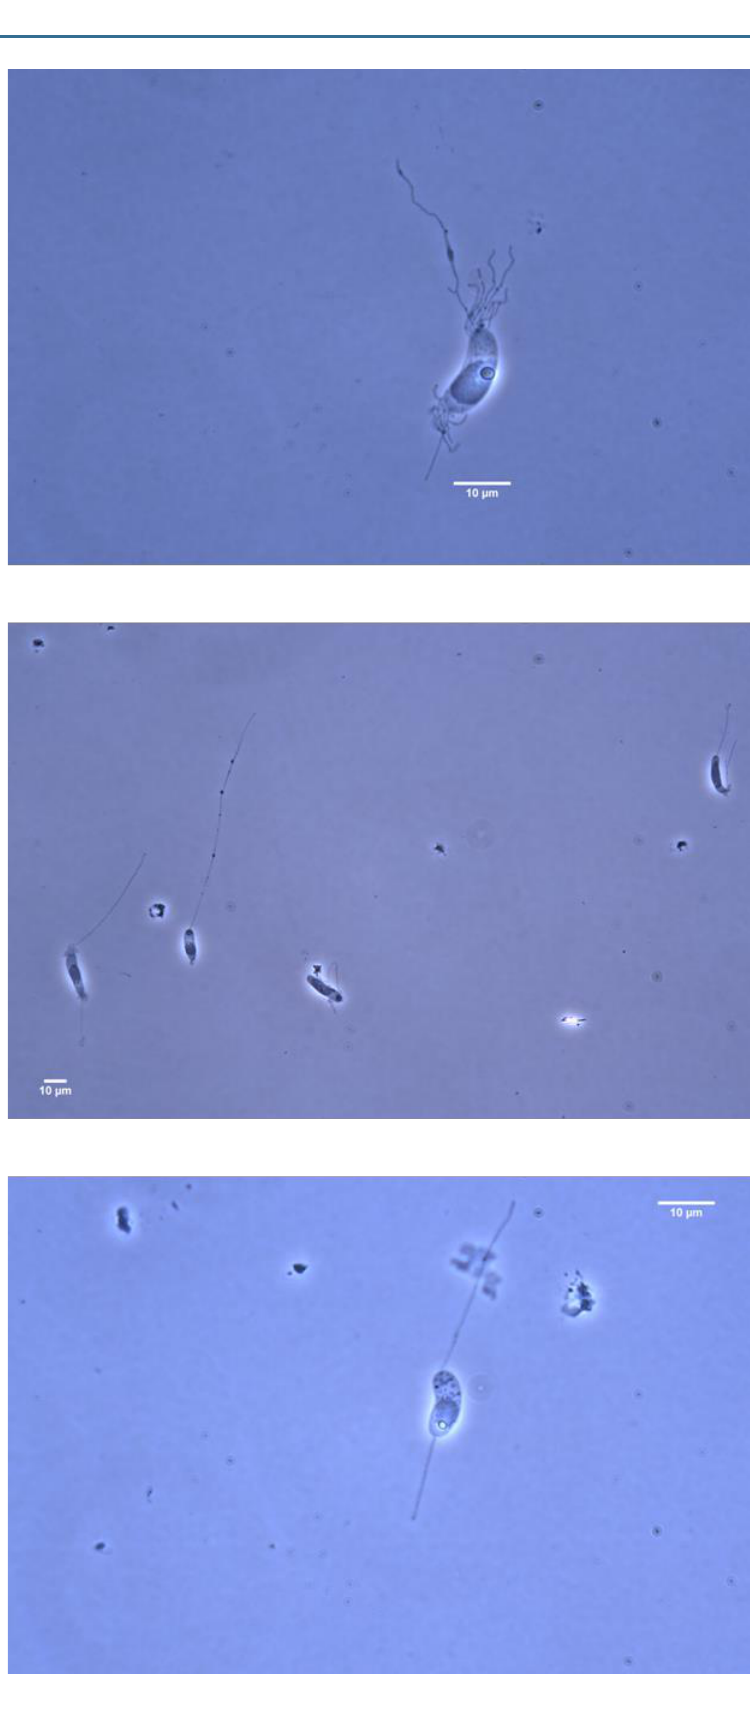
Supplementary figure 3: Examples of Daphnia longispina sperm